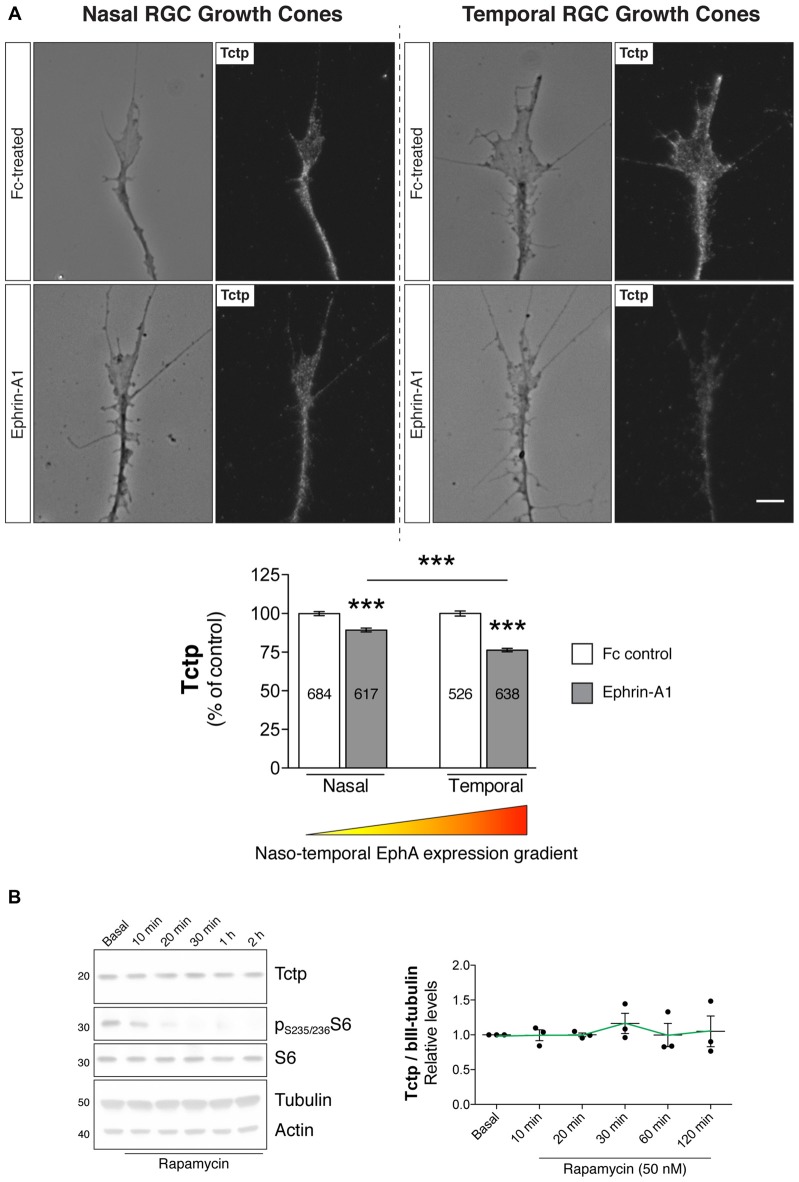
Ephrin-A1 reduces growth cone Tctp expression levels. (A) Nasal and temporal stage 32 retinal explants grown in vitro for 24 h were stimulated with Ephrin-A1-Fc at a concentration of 5 μg/mL, and stained for Tctp. Representative micrographs of control (clustered Fc)- and Ephrin-A1-treated RGC growth cones are shown (mean ± SEM; n = no. of growth cones analyzed; ***P < 0.0001, one-way ANOVA and Tukey’s Multiple Comparison Test). (B) Rat primary cortical neurons were incubated with rapamycin at 50 nM for up to 2 h and Tctp protein levels evaluated in whole cell extracts at various time points (mean ± SEM; n = 3 biological replicates; P = 0.9282, one-way ANOVA). Scale bar: 5 μm.